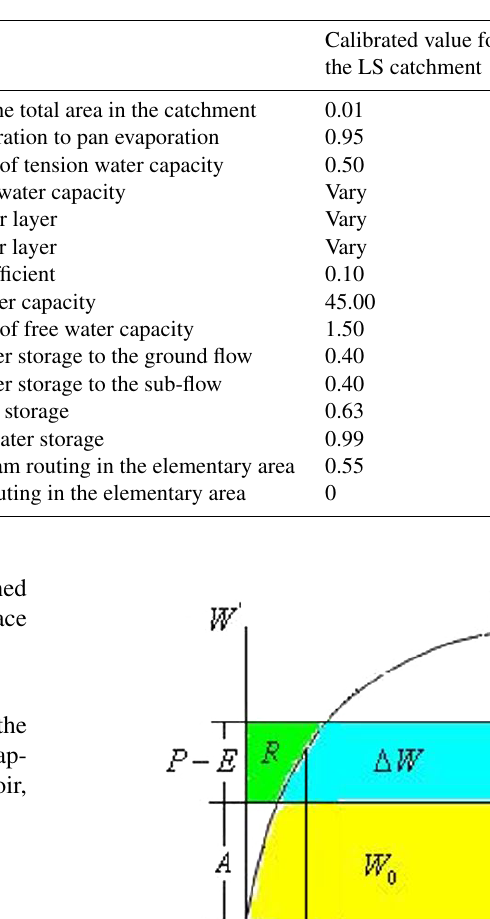
Table 1. Parameter symbols and corresponding definitions in the XAJ model. Also shown the parameters calibrated for the Lushui(LS) catchment during year 2004 and 2005.